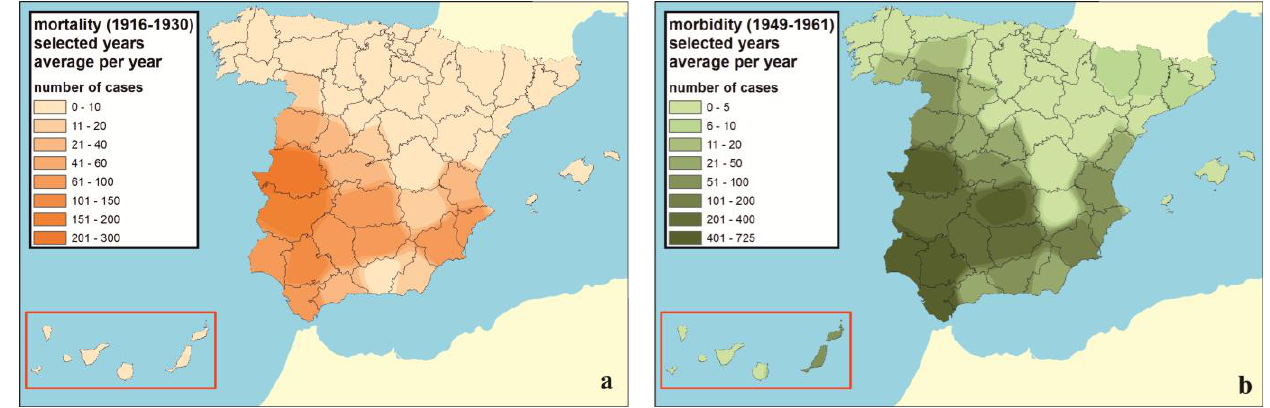
Figure 2. ( a ) Provincial geographical distribution of the average number of deaths by malaria throughout the period between 1915 and 1930. ( b ) Average number of diseased people in 1949 and between 1954 and 1961.